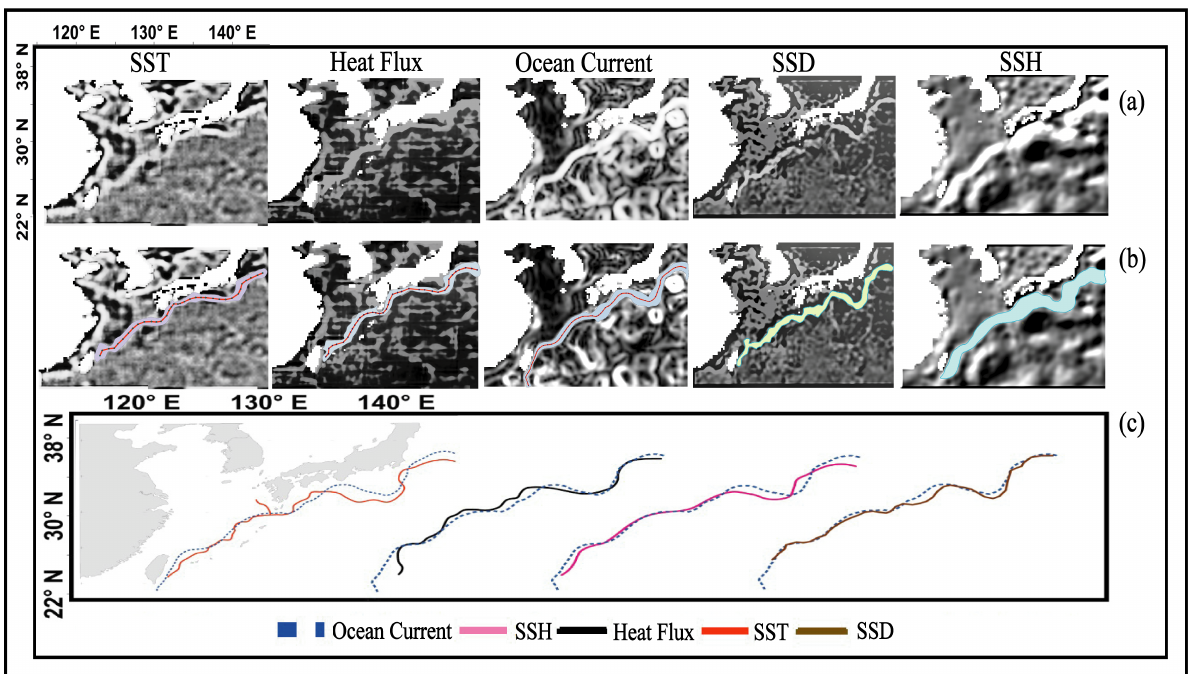
Figure 13. Daily to weekly time scale of satellite based oceanographic data set during typhoon Maria (3–12 July 2018, plus six more days) ( a ) unveiling of Kuroshio by applying combination of spatial filters; ( b ) extracted KC extent with centerline; ( c ) comparison of centerline with sea surface current(blue